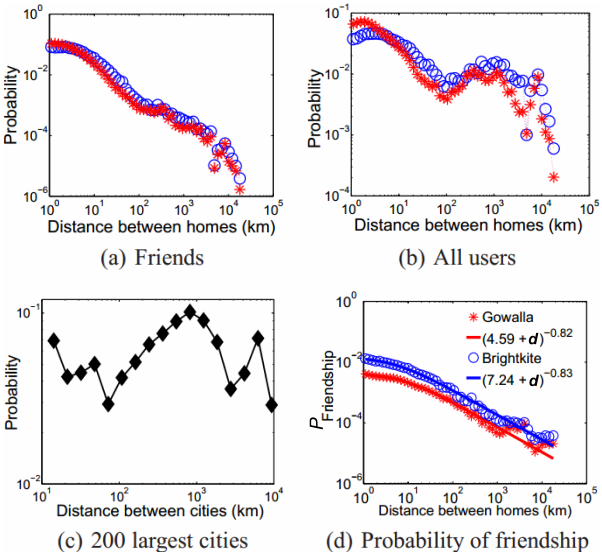
Fig. 8 Distribution of distances between (a) homes of friends, (b) all users, (c) 200 large cities, and (d) the probability of friendship as a function of distance [52] .